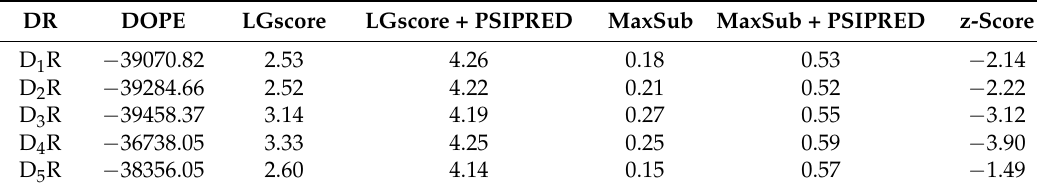
Table 3. Metrics and scores of the final DR homology models used